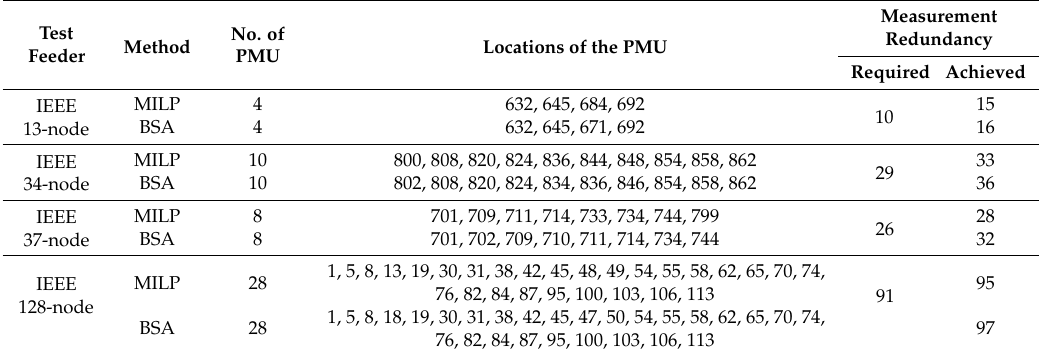
Table 6. Optimal numbers and locations of PMU for different distribution test feeders during the normal operating mode considering ZIB only.